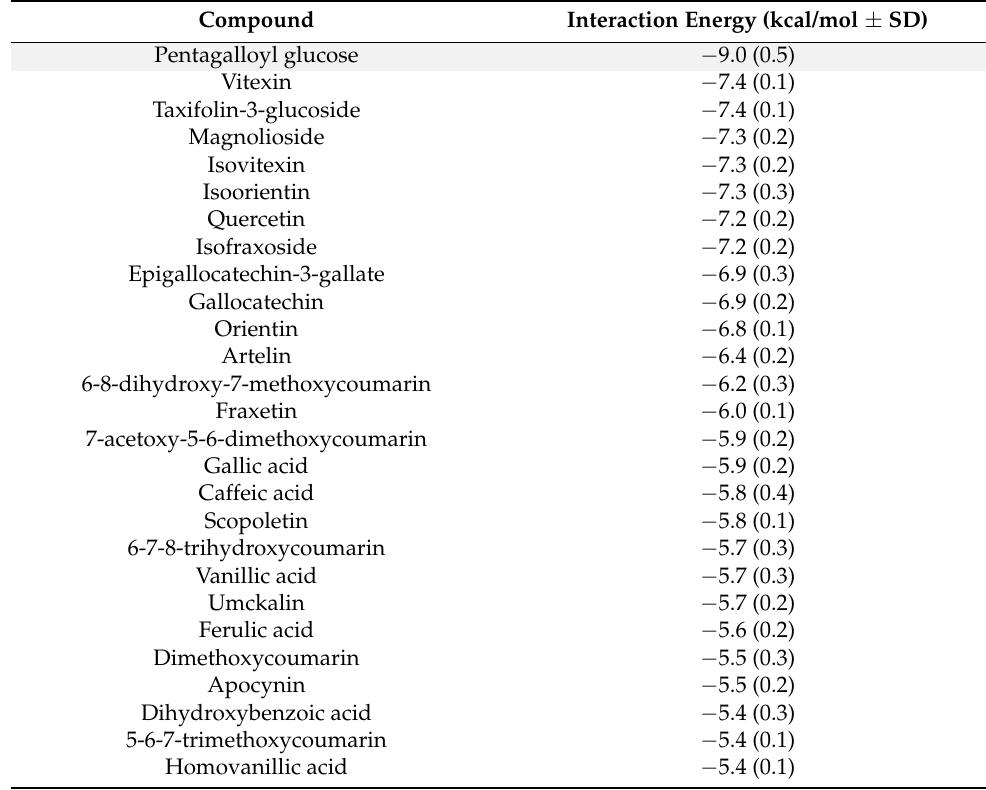
Table 7. RdRp polymersase molecular docking results. The average interaction energy calculated from three independent docking runs, including standard deviation, is reported for each